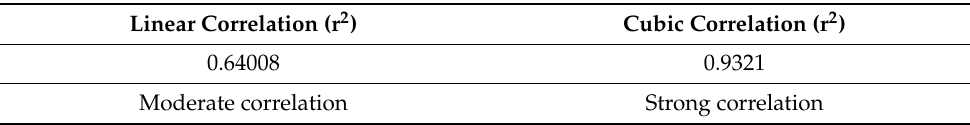
Table 4. The calculated correlations of the linear and cubic